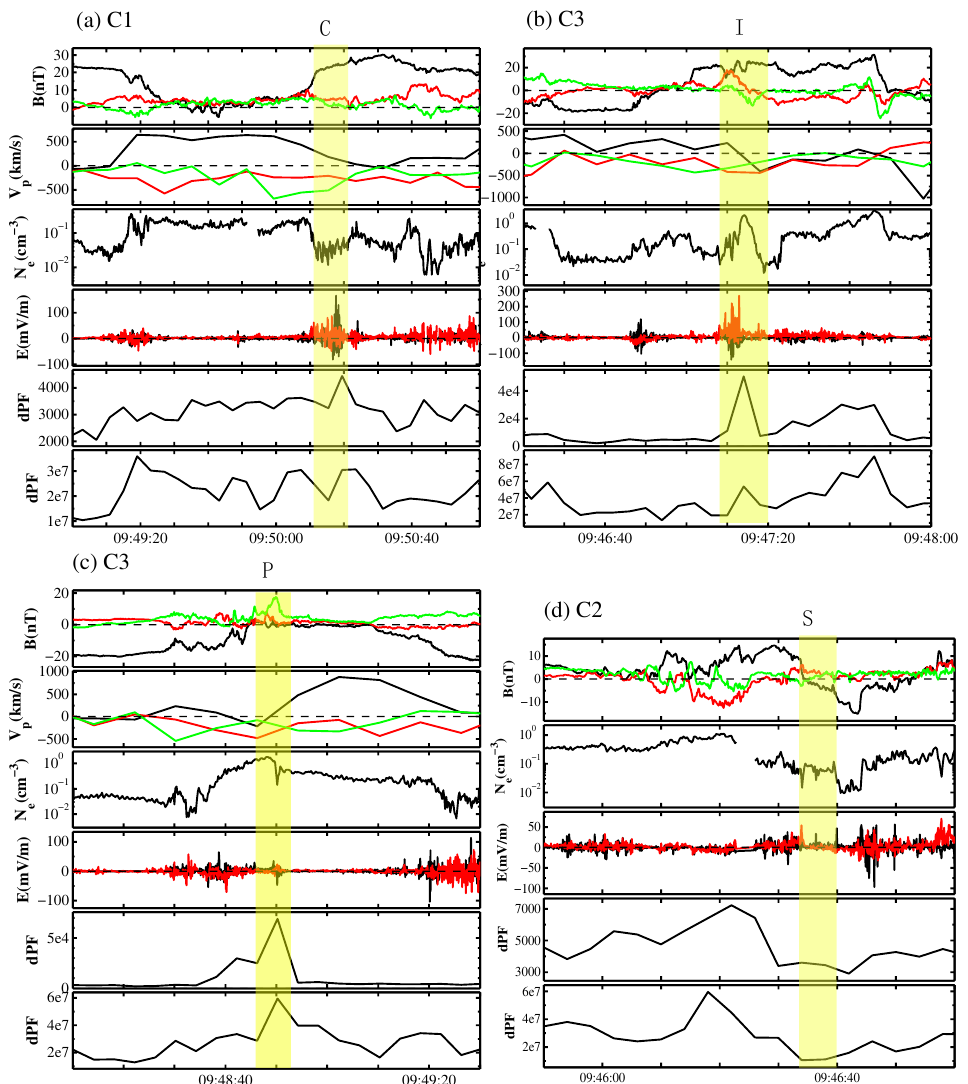
Figure 3. Observations of four structures on 1 October 2001 event: (a) density cavity by C1, (b) magnetic island by C3, (c) flux pileup region by C3 and (d) thin current sheet by C2. Each plot in Fig. 3a-d shows (From the top to bottom) three components of magnetic fields (black: B x , red: B y , green: B z ) , three components of plasma bulk velocity (black: V x , red: V y , green: V z ) , two components of electric fields, electron density, energetic electron differential particle flux (integrated in the range of 50.5–244.1keV), and lower energy electron differential particle flux (integrated in the range of 0.1–26keV). The shaded areas mark the identified structures. Because the CIS instrument of C2 is out of order, panel (d) does not show the plasma bulk